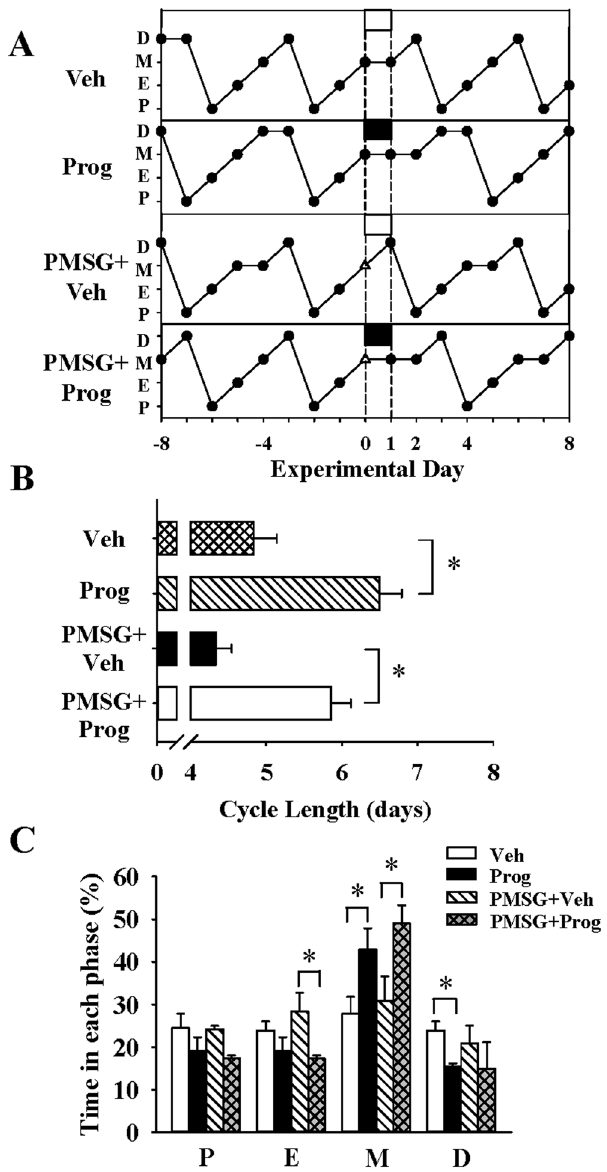
Figure 2. Progesterone disrupted oestrous cyclicity in the female rats. ( A ) Representative profiles depicting oestrous cyclicity in female rats, as measured by vaginal cytology, before (days − 8 to − 1, baseline), during (day 0 to 1, treatment) and after (days 2 to 8, after-treatment) the two day period of treatment from metestrus with vehicle (oil; twice daily) only (Veh, top panel), progesterone (twice daily) only (Prog, second panel), single injection of PMSG (day 0 only) plus vehicle (twice daily) (PMSG + Veh) or single injection of PMSG (day 0 only) plus progesterone (twice daily) (PMSG + Prog, bottom panel) in normal cycling rats. P, proestrus; E, oestrus; M, metestrus; D, diestrus. ( B ) Average oestrous cycle length of the treatment cycle per se . ( C ) Average time spent in each stage of the cycle of the treatment cycle per se . Data were analysed by two-way ANOVA. * P < 0.05, Veh vs Prog; n = 5–7 per Effects of progesterone on the LH surge in PMSG-primed rat. As expected from the proestrus smear, all vehicle injected PMSG-primed animals displayed a robust LH surge on the afternoon/evening of day 2 (day 0, PMSG treatment) (Fig. 3A,E and F). In contrast, none of the PMSG-primed females administered progesterone displayed an LH surge (Fig. 3B,E and F). Area under curve (AUC) analysis of the LH profile (12:00–20:00 h) on day 2 is shown in Fig. 3F. Circulating progesterone levels were significantly elevated at 18:00 h on experimental day 0 post injection (124.62 ± 43.62 vs 22.79 ± 5.64 ng/ml vehicle control; P < 0.05) (Fig. 3C). Circulating levels of E 2 measured on the afternoon of day 1, before the expected LH surge, as a measure of follicle development, did not differ between PMSG-primed female treated with vehicle or progesterone (224.1 ± 66.1 vs 254.2 ± 76.3 pg/ml, respectively; P > 0.05) (Fig. 3D).